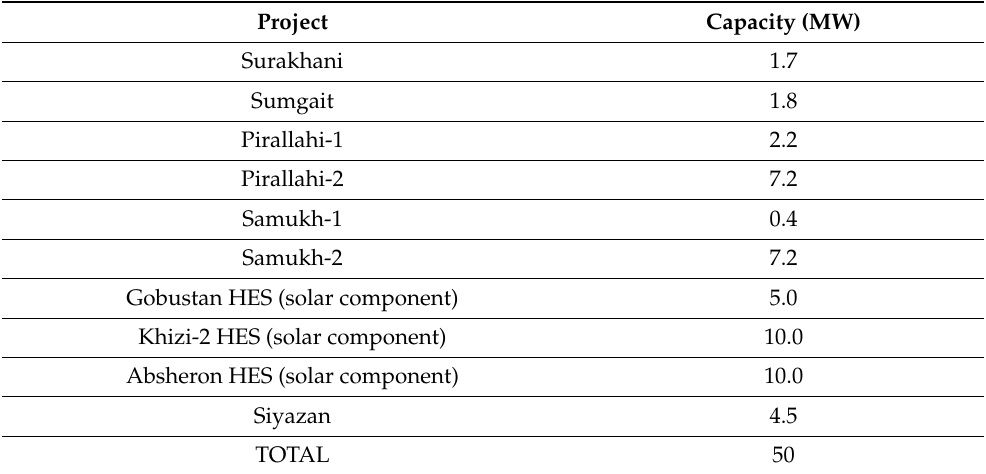
Table 6. List of projected solar plants in Azerbaijan in 2018 [19].